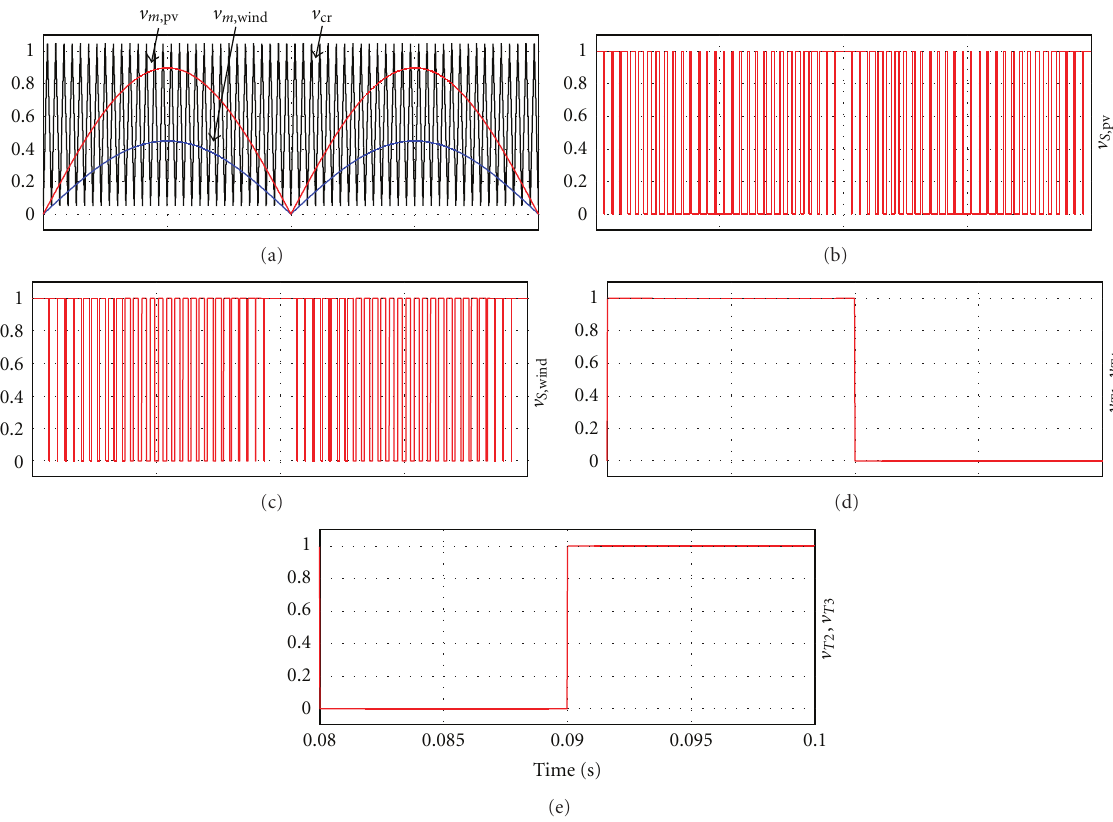
Figure 12: PWM switching strategy (top to bottom) v m ,pv , v m ,wind , v cr , v S ,pv , v S ,wind , v T 1 , v T 4 , v T 2 , and v T 3 .